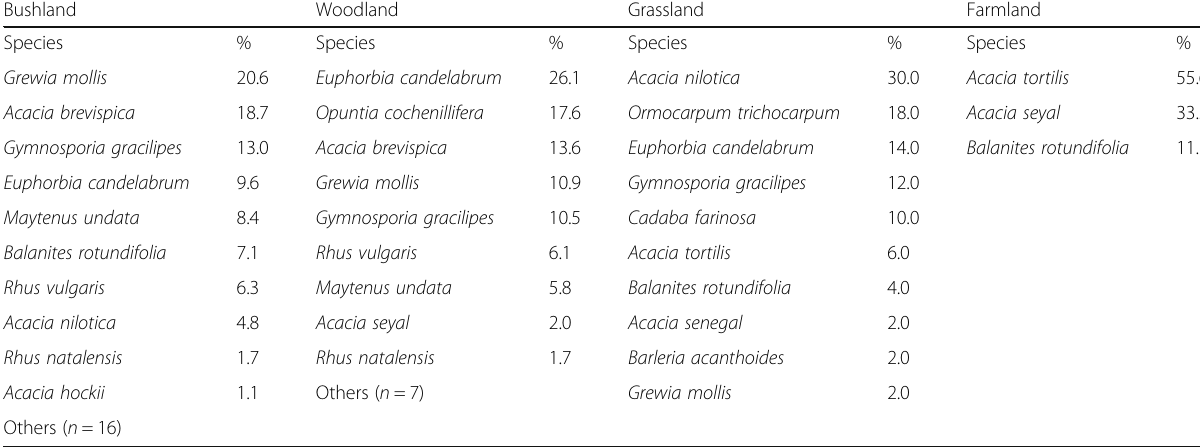
Table 1 Relative abundance of wood species among land cover types of Moroto district